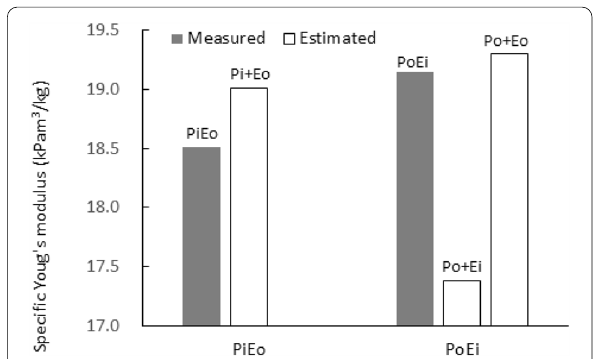
Fig. 9 Comparison between the mixed-species LVL and the average of two types of mono-species LVL in specific Young’s modulus